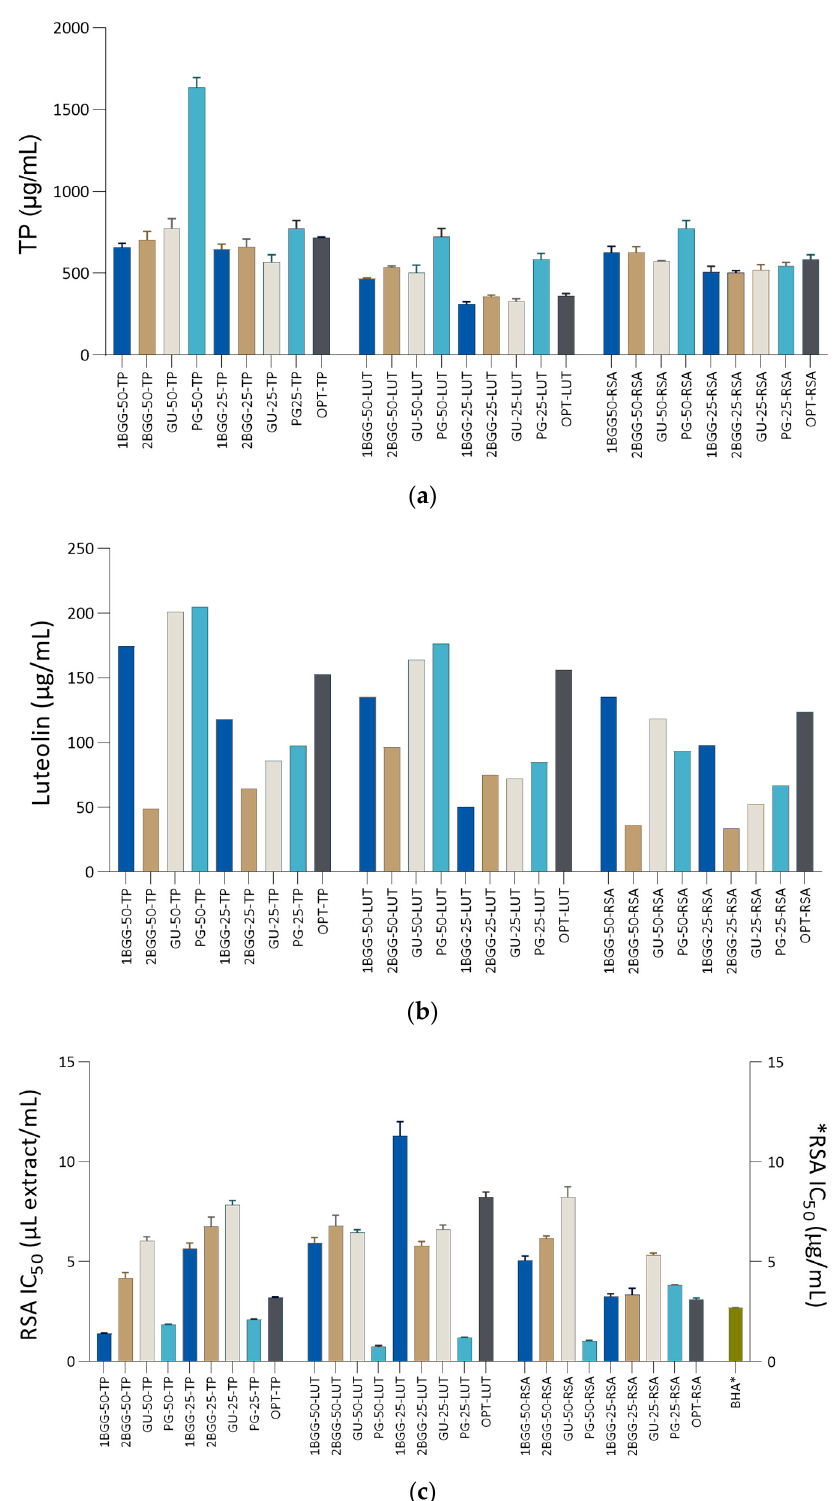
Figure 1. Comparison of NADES and optimal extracts based on responses: ( a ) total phenolic content (TP), ( b ) luteolin content, and ( c ) radical scavenging activity (RSA). Values in ( a , c ) are average of three replications ± SD. BHA = butylated hydroxyanisole. Asterisk indicates that the unit is placed at the right ordinate. Abbreviated names for NADES-based extracts are explained in Section 3.3.